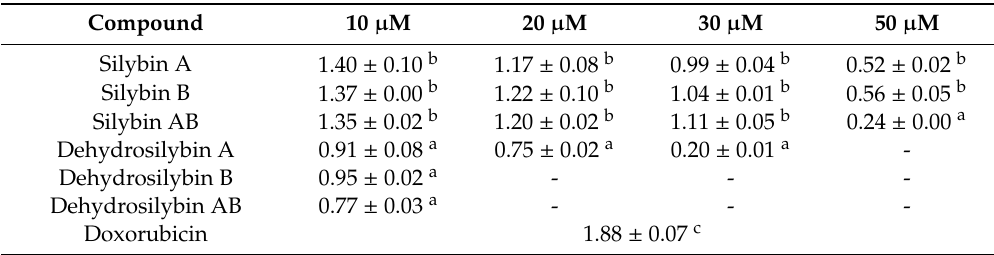
Table 8. The sensitization e ff ect of silybin and dehydrosilybin stereomers on the e ff ective dose of doxorubicin inhibiting the viability of doxorubicin-resistant human ovarian carcinoma cells (A2780 / DOX).